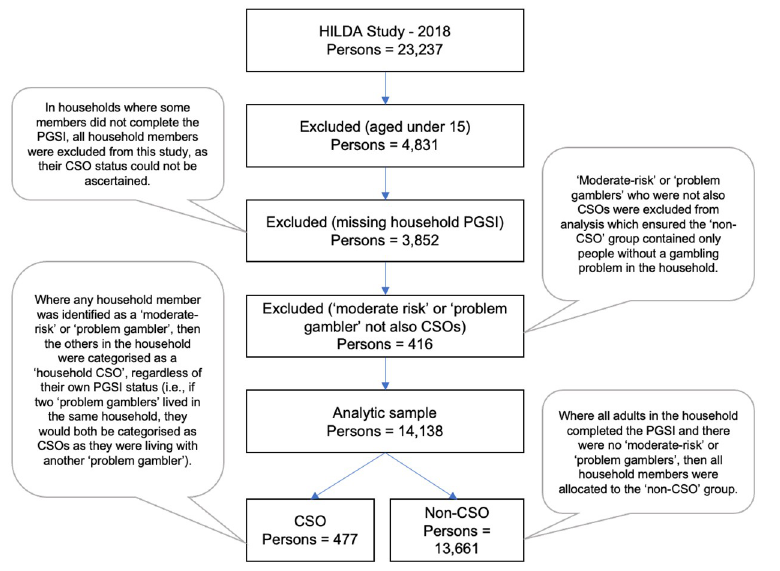
Fig 1. Primary sample selection, HILDA